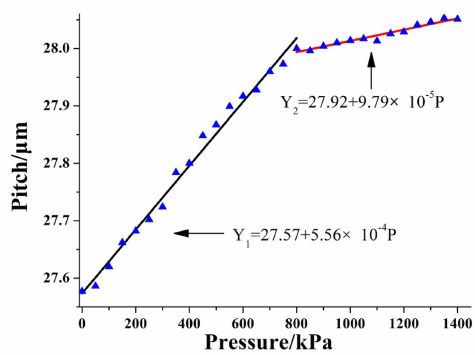
Figure 8. The relationship of pitch distance d and the filling pressure.